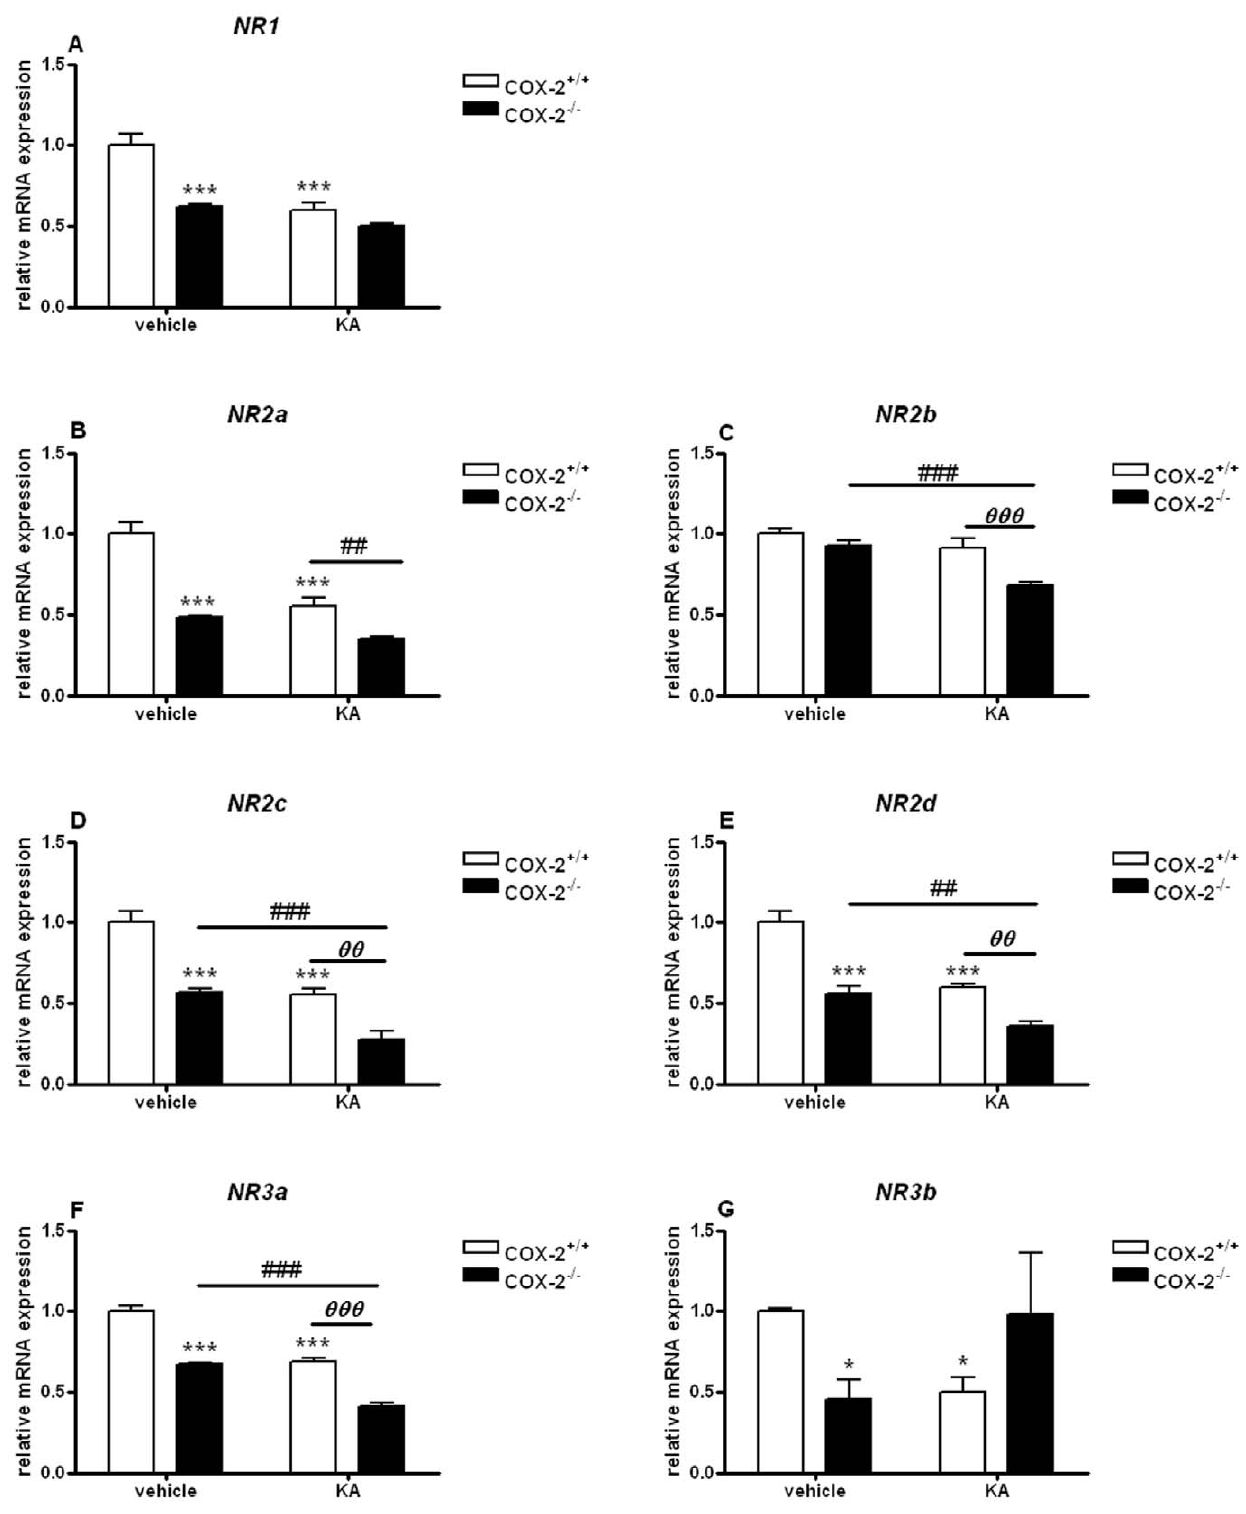
Figure 3. KA-induced expression of NMDA receptor subunits in the hippocampus of COX-2 + / + and COX-2 2 / 2 mice. Quantitative real time-PCR analysis of NR1 (A), NR2a (B), NR2b (C), NR2c (D), NR2d (E) NR3a (F), NR3b (G) for COX-2 + / + and COX-2 2 / 2 mice 24 h after i.p. injection of KA or vehicle. Data are means 6 SEM ( n =9). Statistical analysis was performed using a two-way ANOVA and Bonferroni’s post-hoc test to compare replicate means. *P , 0.05, **P , 0.01, *** P , 0.001 compared to vehicle-injected COX-2 + / + mice; # P , 0.05, ## P , 0.01, ### P , 0.001, compared to vehicle- injected COX-2 2 / 2 mice; fi P , 0.05, fifi P , 0.01, fififi P , 0.001 between KA-injected COX-2 2 / 2 and KA-injected WT mice.